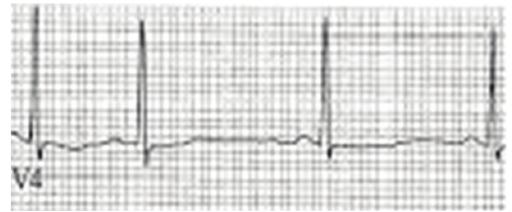
Figure 1: Evidence of NSTEMI, along with elevated troponins; the patient underwent cardiac stent placement.